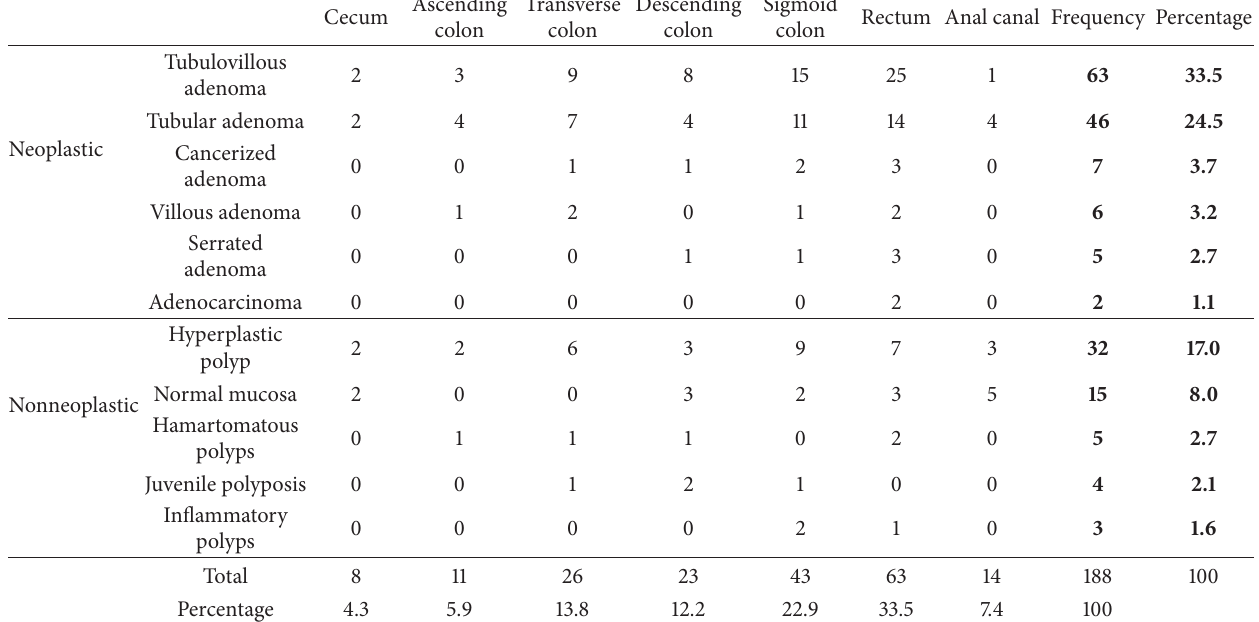
Table 2: Histology of polyps (all polyps